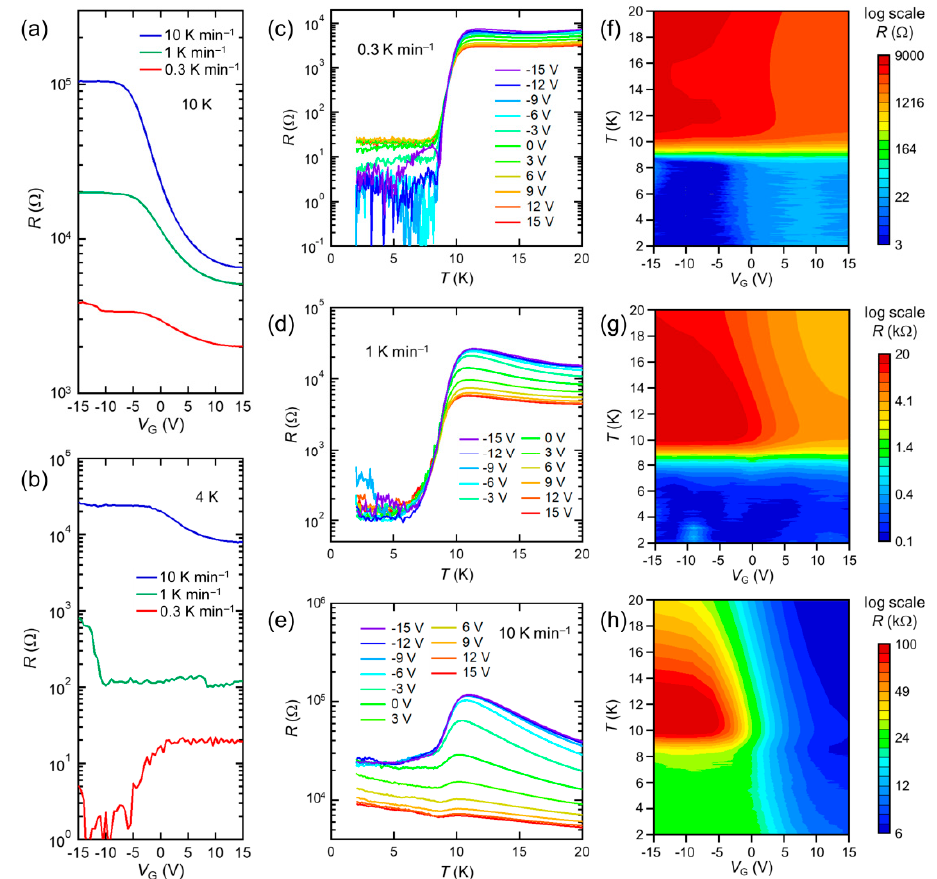
Figure 2. Gate voltage V G dependence of resistance of device1 at 10 K ( a ) and 4 K ( b ) with different cooling rates. Temperature dependence of resistance of device1 below 20 K under various V G at cooling rates of 0.3 K min –1 ( c ), 1 K min –1 ( d ), and 10 K min –1 ( e ). Color plots of resistance below 20 K against V G and temperature at cooling rates of 0.3 K min –1 ( f ), 1 K min –1 ( g ), and 10 K min –1 ( h ).